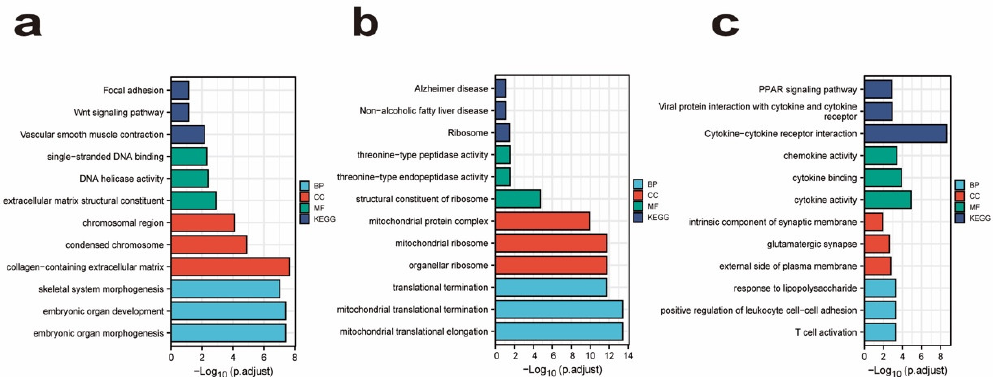
Figure 2. GO functional and KEGG pathway enrichment analysis of DEGs. GO functional analysis showing enrichment of DEGs in biological process ( a ), molecular function ( b ) and cellular component ( c ). KEGG pathway enrichment analysis of DEGs.